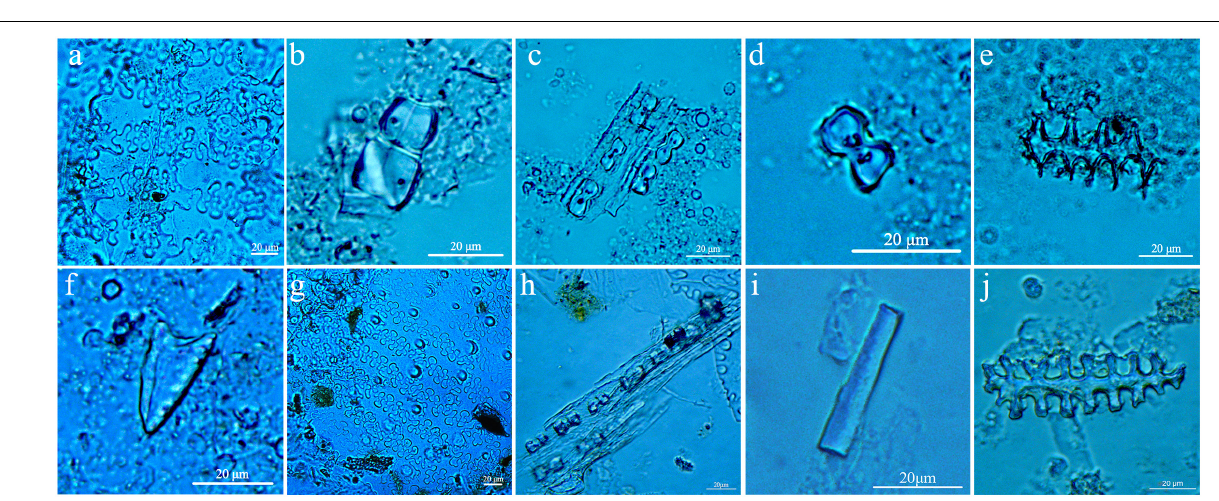
FIGURE 4 | Primary phytolith types found at Longzaocun cemetery M111, (a) (cid:127) -type from foxtail millet; (b) long-saddle; (c) vertically arranged bilobates with rounded ends; (d) bilobate; (e) elongate-echinate; (f) acicular; (g) (cid:127) -type; (h) vertically arranged bilobates with rounded ends; (i) smooth-elongate; (j)